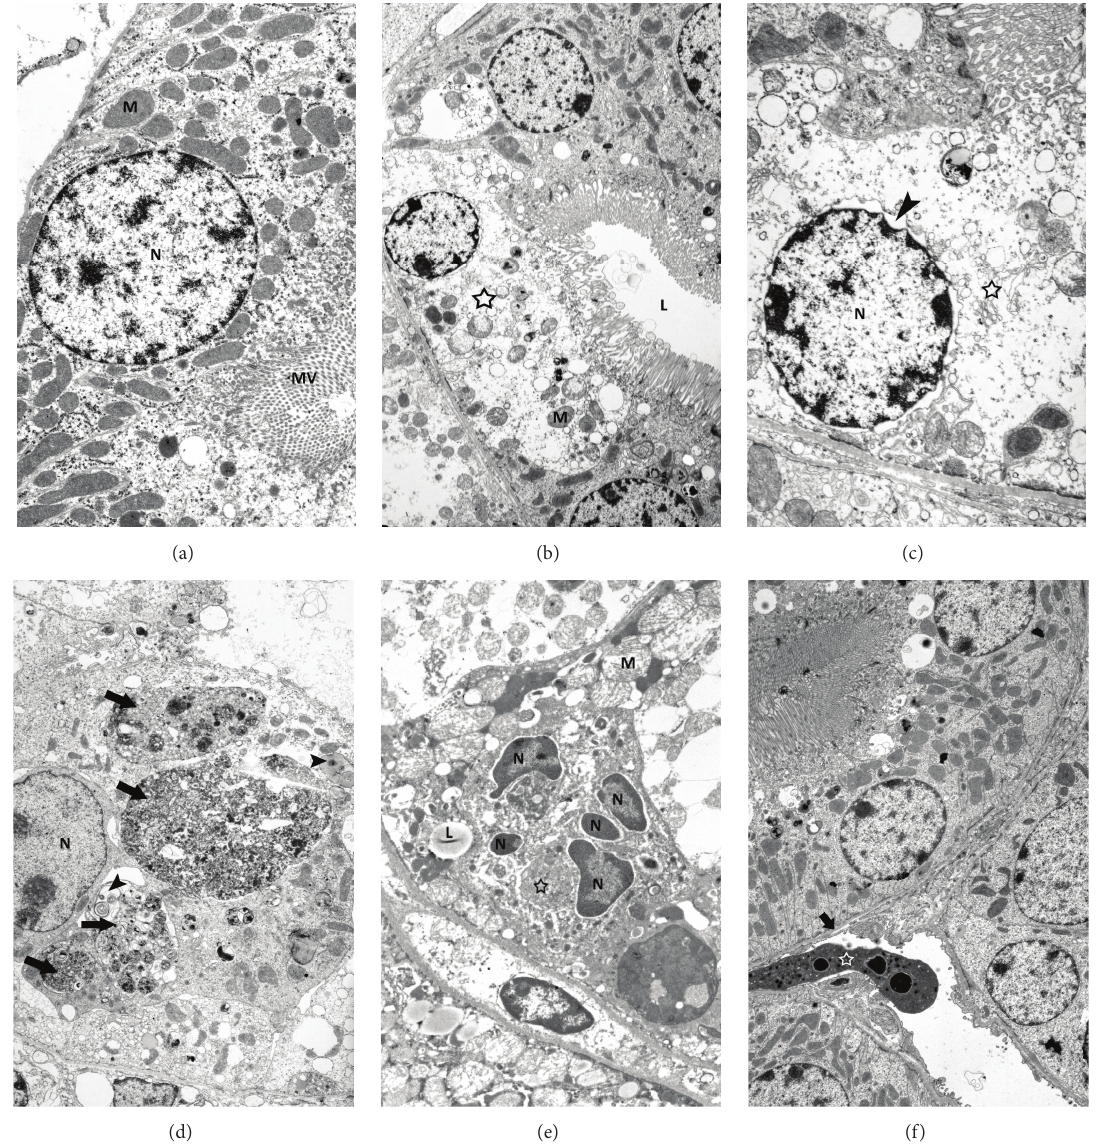
Figure 5: Kidney ultrastructure. (a) Ultrastructure of epithelial cell with large and rounded nucleus (N), numerous mitochondria (M), and pronounced microvilli (MV). (b) Necrotic epithelial cell (asterisk) with typical ultrastructural signs of necrosis such as electron pale and disintegrated cytoplasm, disrupted microvilli, and few mitochondria (M). L-lumen of proximal tubule. (c) Details of necrotic epithelial cell with strongly dilated perinuclear space (arrowhead), ruptured Golgi apparatus (asterisk), and highly demolished cytoplasmic integrity with hardly recognizable structures. (d) Epithelial cell with no brush border on apical surface, multilamellar bodies (arrowheads), and extremely large autophagic vacuoles (arrows) and fulfilling the entire cytoplasm. N-nucleus. (e) Apoptotic epithelial cell with condensed chromatin in nuclear fragments (N), lipid droplets (L), disappeared microvilli, and electron dense and condensed cytoplasm (asterisk). (f) Epithelial cells of proximal tubule with normal ultrastructure. Under basal lamina (arrow) of tubule, peritubular cell (asterisk) of connective tissue with typical signs of apoptosis such as cytoplasm condensation and chromatin fragmentation and condensation is present. Representative TEM images of kidney samples taken from control mice (a), mice receiving ATG and cisplatin (b–d), and mice receiving MSCs after ATG and cisplatin (e, f). Original magnifications: × 4400 (a), × 2600 (b), × 5800 (c), × 2600 (d), × 4400 (e), and × 2000